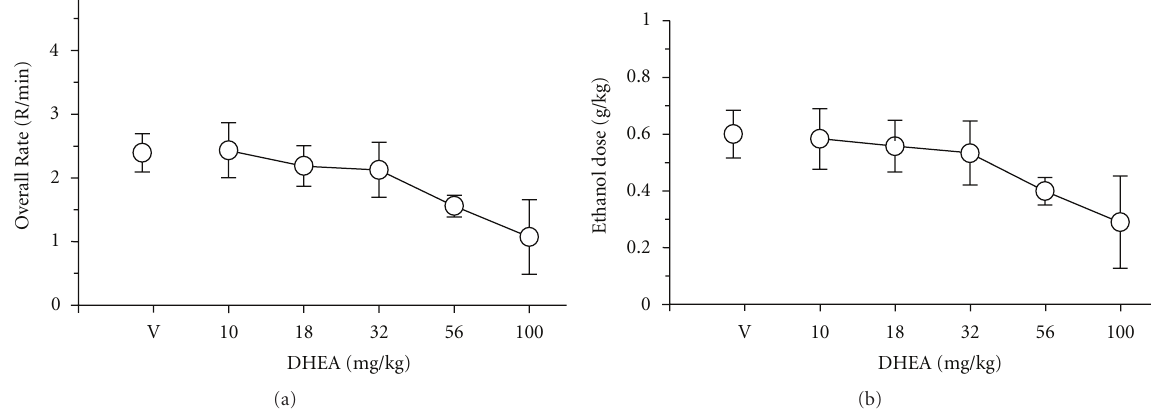
Figure 5: E ff ects of intraperitoneal administration of DHEA on rats ( n = 5) responding under an FR-10 schedule for 0.1 mL of 18% (v/v) ethanol. The dependent measures were response rate in responses/min and the dose of ethanol presented in g/kg. The points and vertical lines above “V” indicate the means and standard error of the mean (SEM) for sessions in which vehicle was administered (control). The points with vertical lines in the dose-e ff ect data indicate the mean ± SEM for sessions in which DHEA was administered. The points without vertical lines indicate instances in which the SEM is encompassed by the